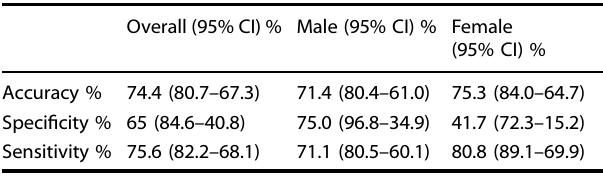
Table of the averages of the accuracies, the speci fi cities, and the sensitivities of test samples (CTR and dn 2 PD) on the OPLS-DA training